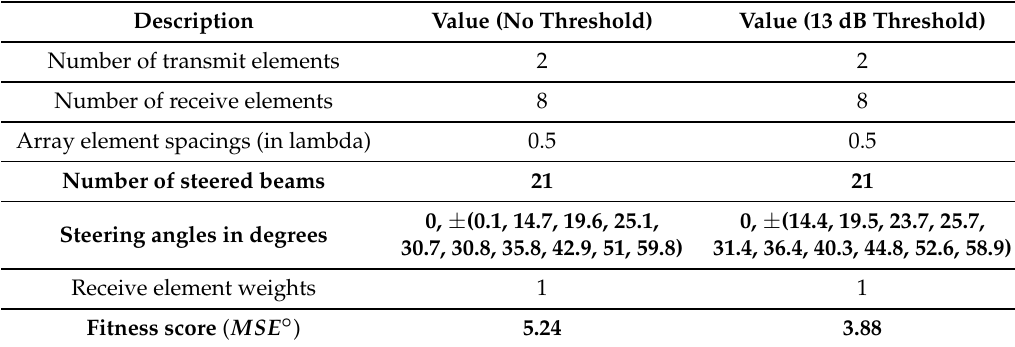
Table 7. Experiment 1 results.